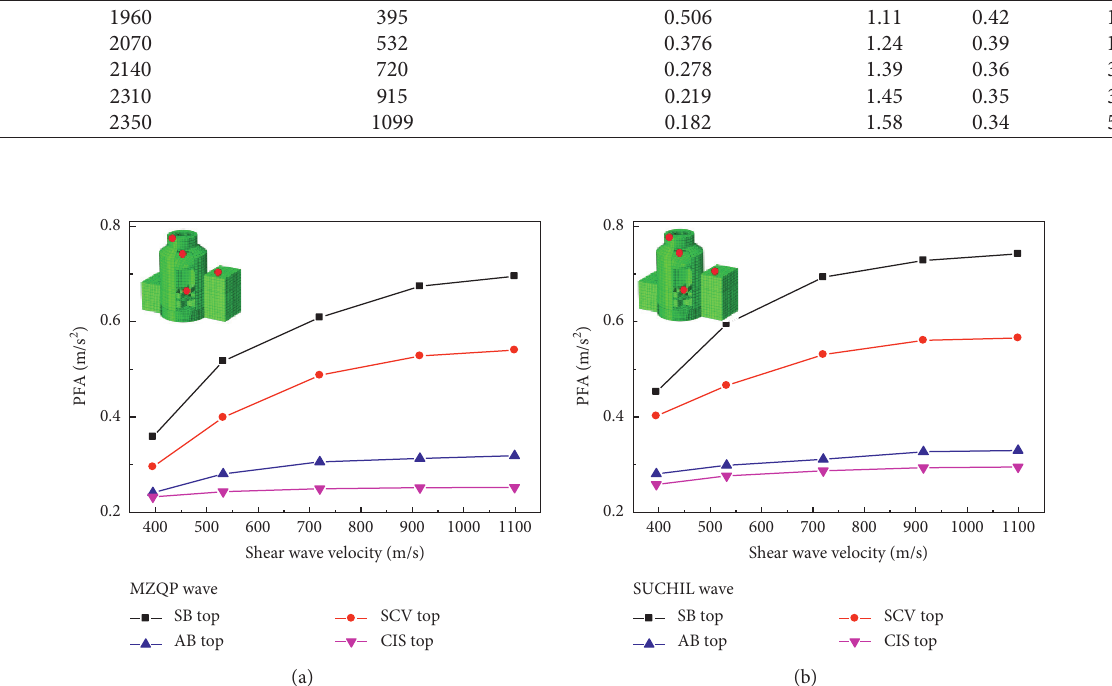
Figure 14: Relationship between the shear wave velocity of the SR site and the PFA of the nuclear island structure.